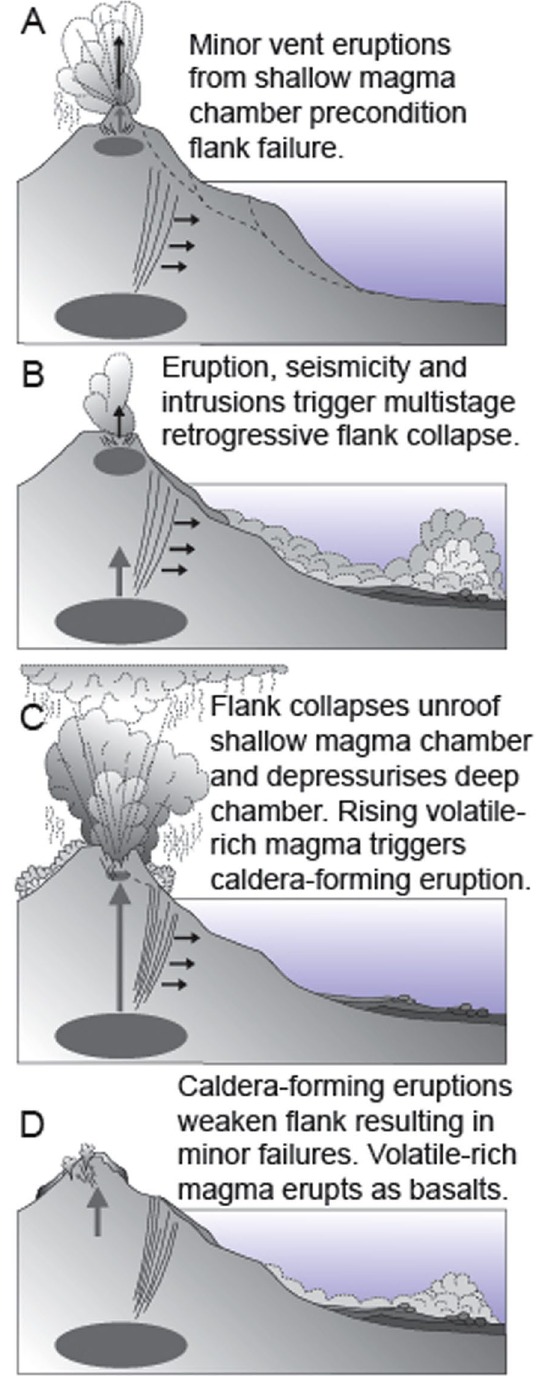
Figure 5. Idealised model for the relationship between the multistage Icod, Orotava and Roques de Garcia landslides and the Abrigo, Granadilla and terminal Ucanca Formation caldera-forming eruptions. ( A ) Minor vent related volcanism and shallow magma chamber activity precondition the submarine slopes to fail. ( B ) Minor eruptions and related seismicity trigger initial submarine stages of multi-stage landslides. ( C ) Submarine landslides unroof both shallow and deep magma chambers, this either (i) caused static decompression in the shallow magma chamber causing immediate explosive eruption, or (ii) static decompression at depth causing ascension of volatile-rich basalt magma that mixes with otherwise volatile undersaturated shallow magma to trigger explosive eruption. ( D ) Explosive or caldera-formning eruptions weaken edifice flanks resulting in subaerial stages of multi-stage failure, containing volcanic debris from explosive